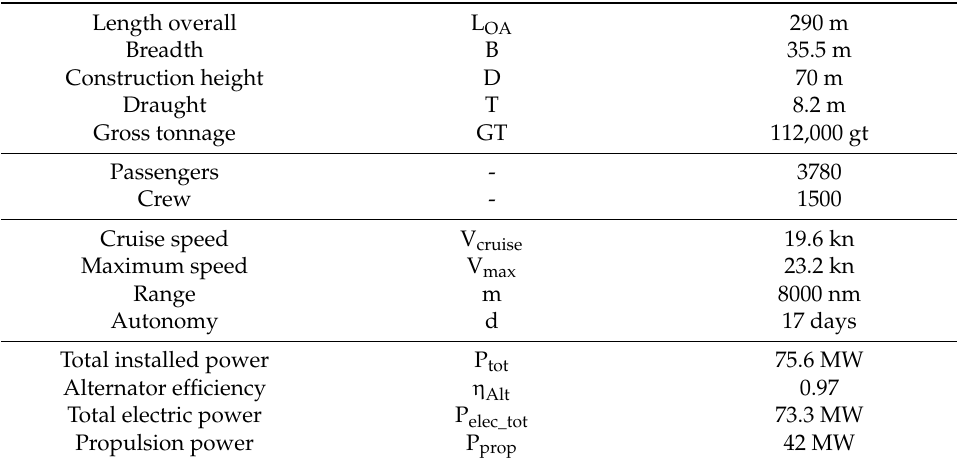
Table 2. Main characteristics of the reference ship.